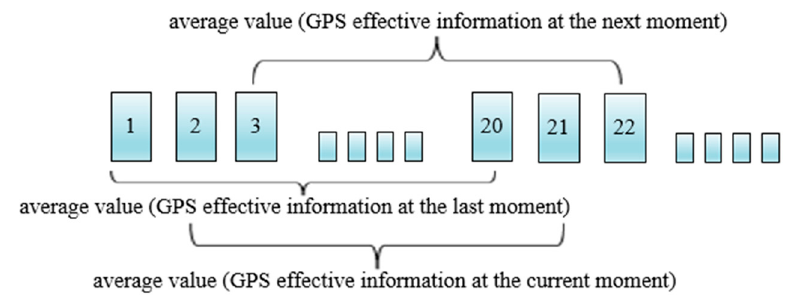
Figure 3. The principle of dynamic mean method (e.g., the 20th GPS information is the average of 1–